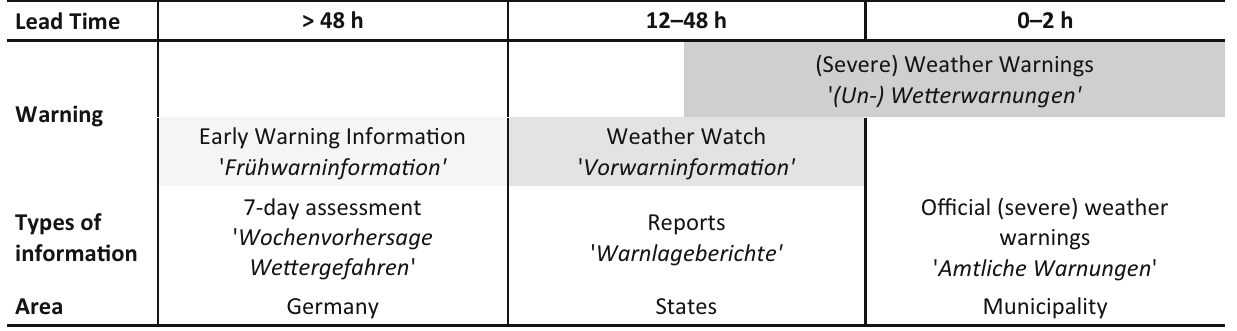
Table 1 Official weather warning steps in Germany